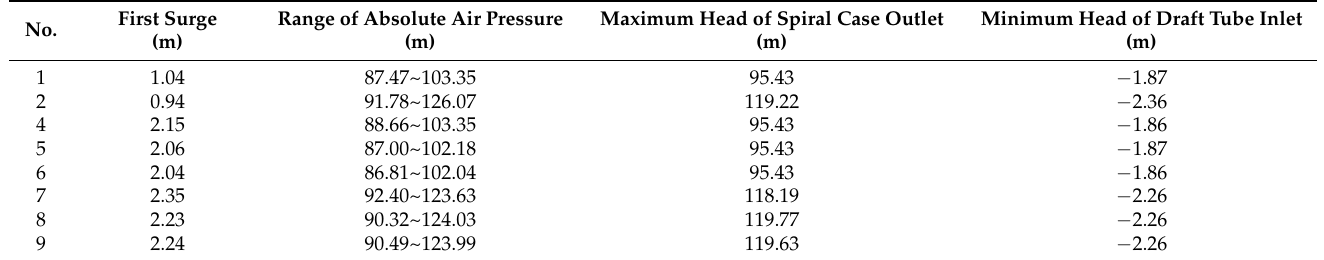
Table 6. Numerical Results under LLD